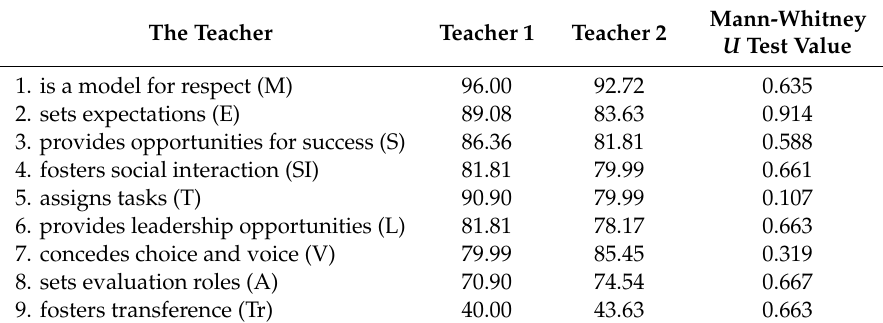
Table 1. Teachers’ strategies used to promote